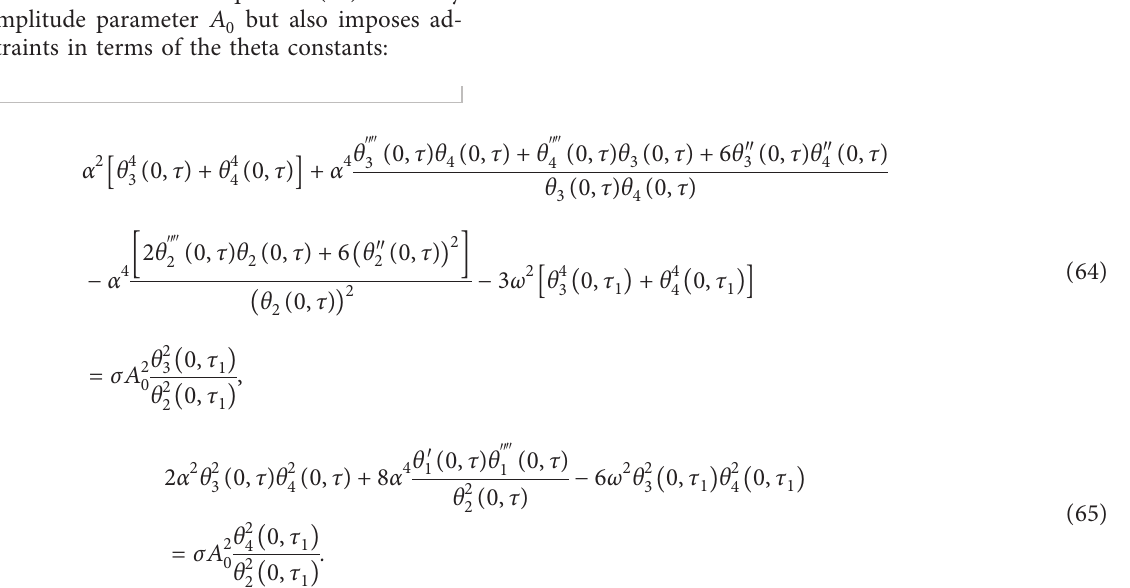
� − ( π /6 ) . The panels (b) and (d) are the contour plots of the panels (a) and (c), 5